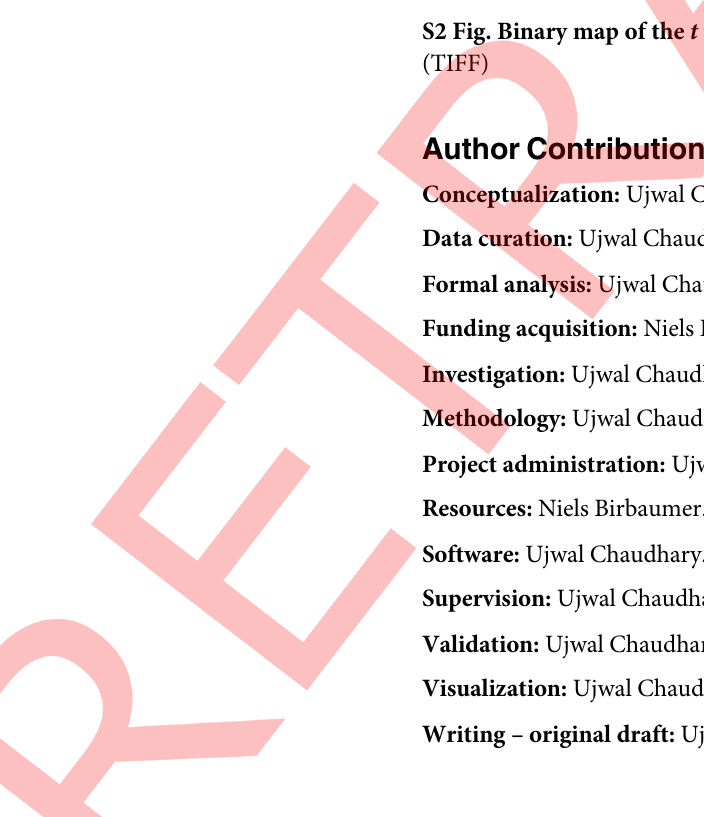
S2 Fig. Binary map of the t test between “yes” and “no”